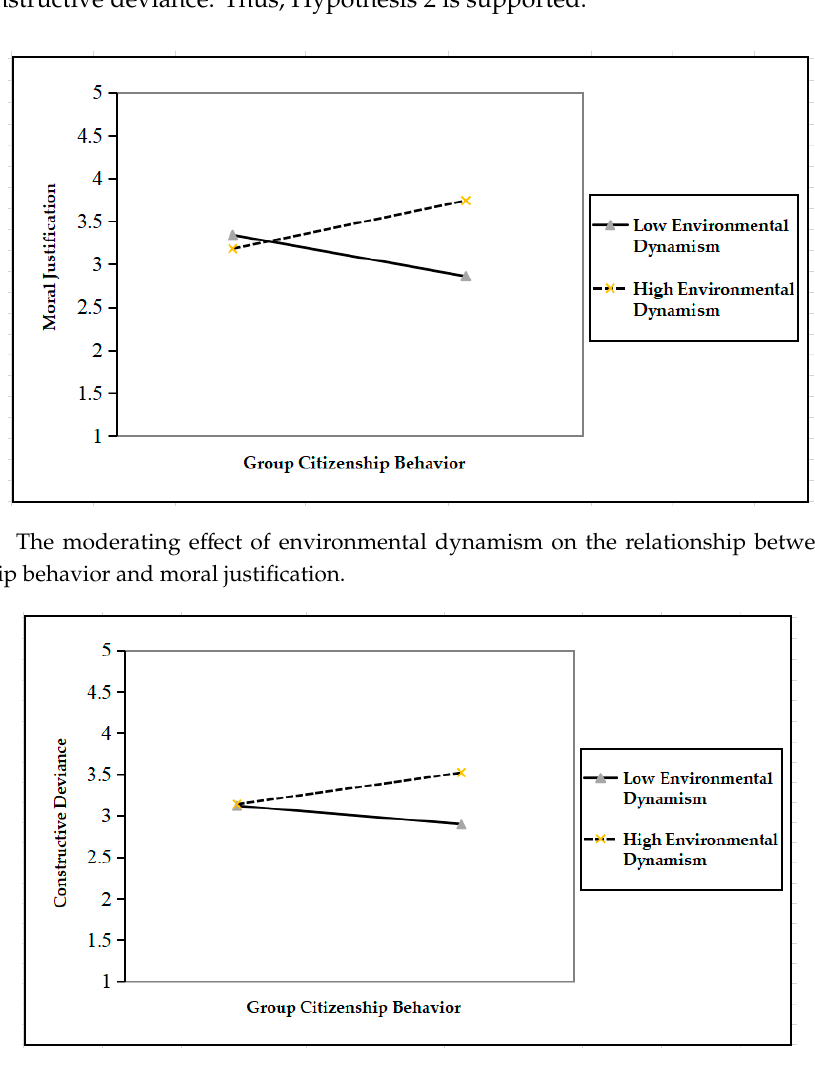
Figure 3. The moderating effect of environment dynamism on the relationship between group citizenship behavior and constructive deviance.